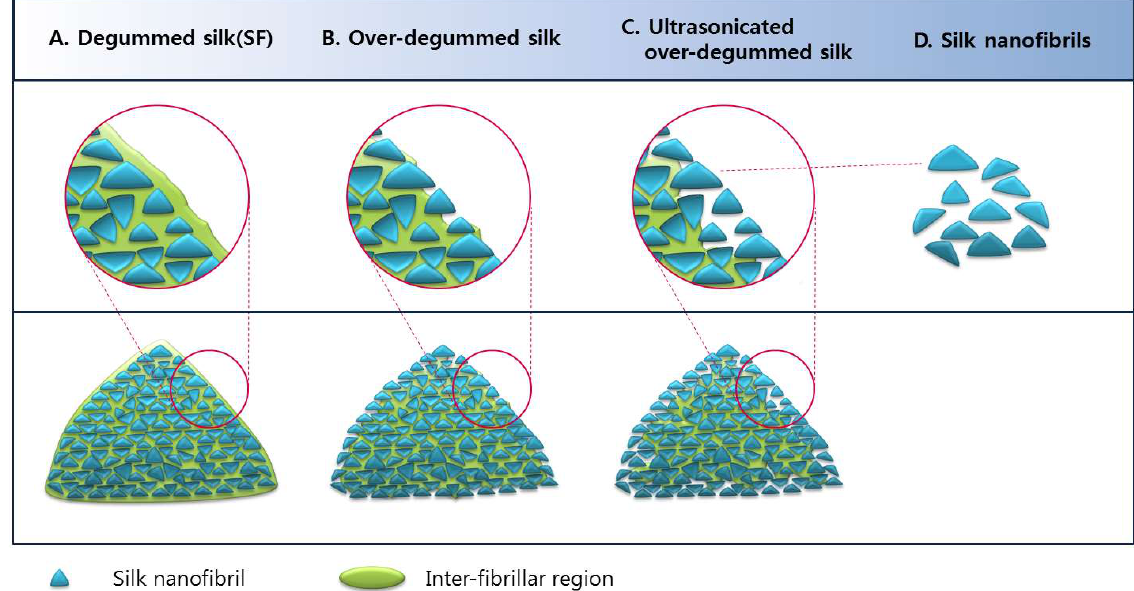
Figure 4. Schematic representation of the structure of SF and occurrence of silk nanofibrils on SF.